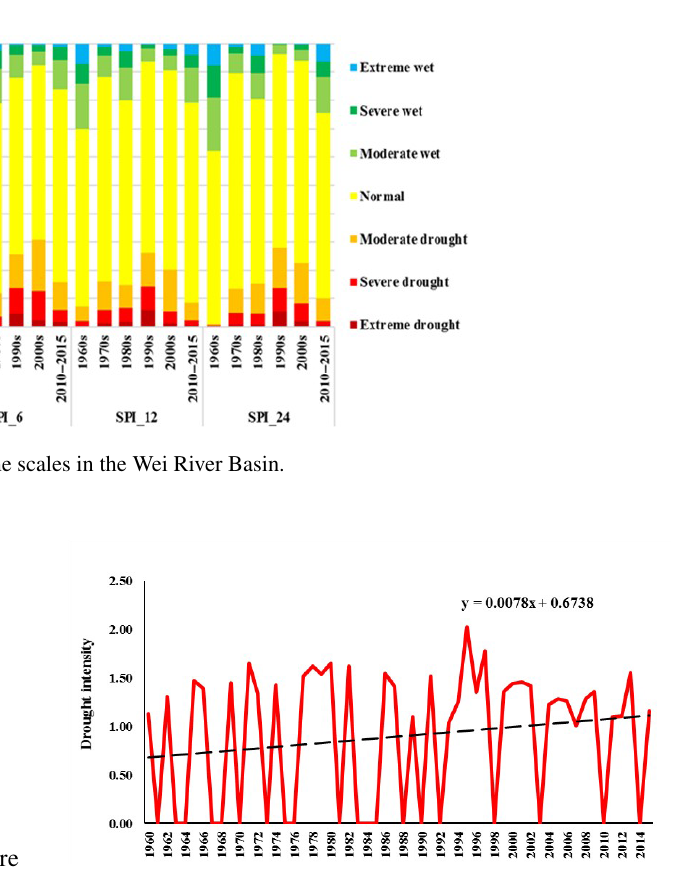
Figure 4. The variation of drought intensity in the Wei River Basin during